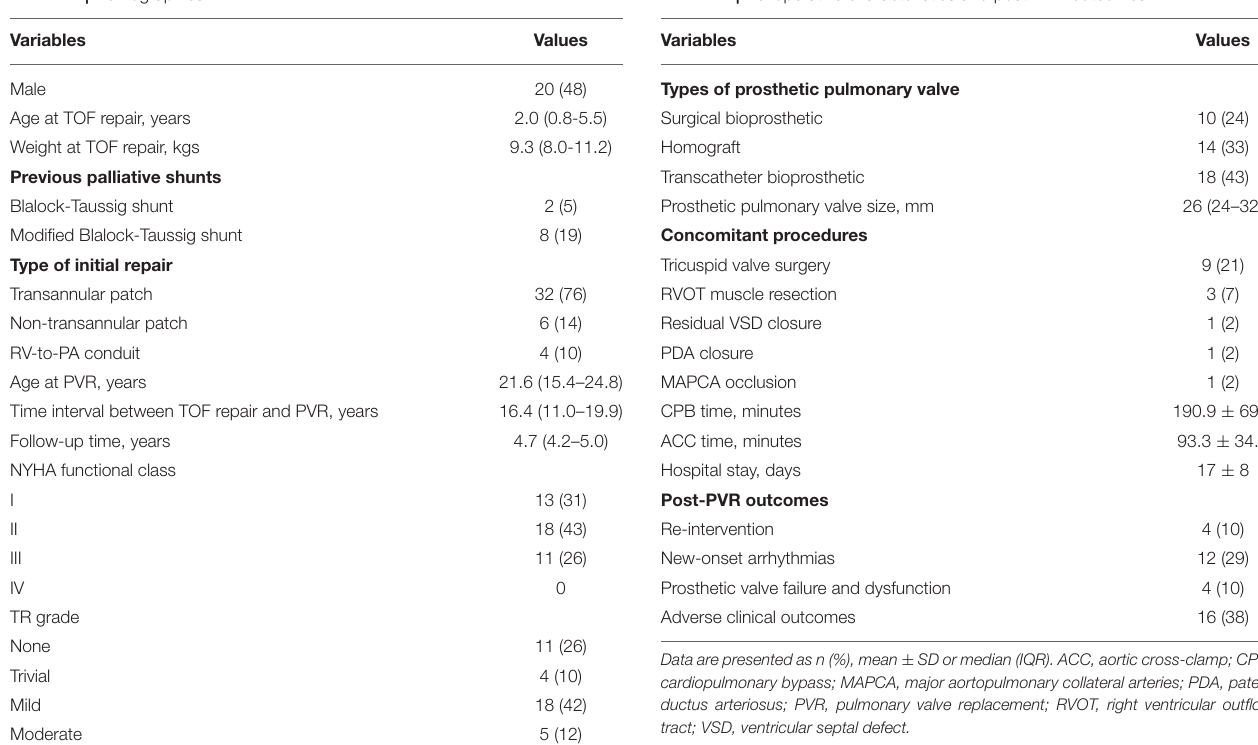
TABLE 2 | Perioperative characteristics and post-PVR